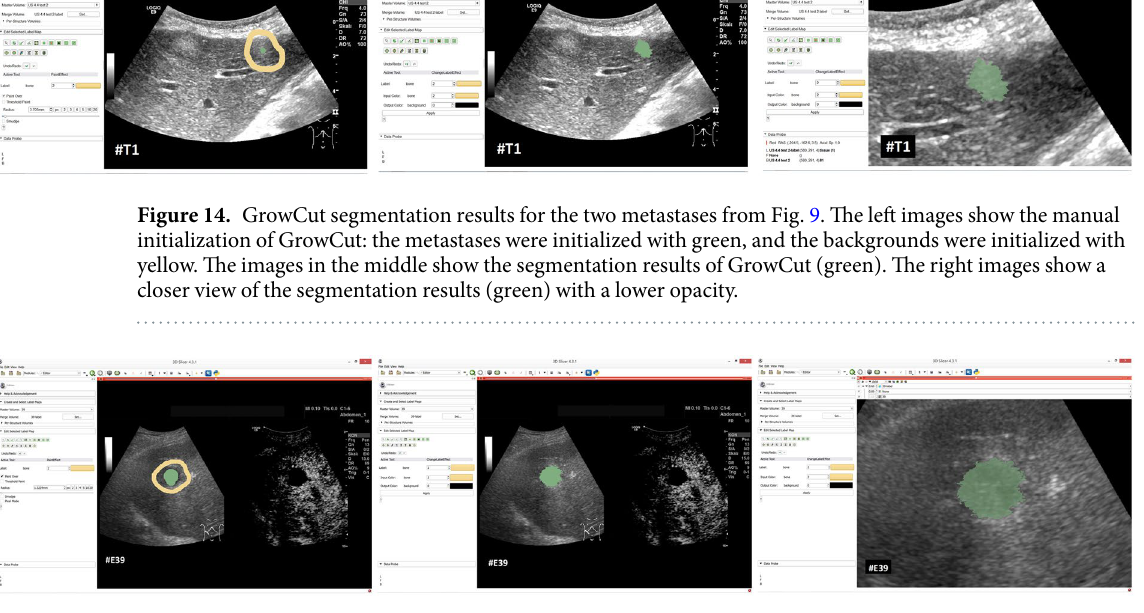
Figure 15. GrowCut segmentation results for a pancreas metastasis. Equivalent to Fig. 14, the left image shows the manual initialization of GrowCut: the pancreas metastasis was initialized with green, and the background was initialized with yellow. The image in the middle shows the segmentation result of GrowCut (green). The right image shows a closer view of the segmentation result (green) with a lower opacity (0.6).